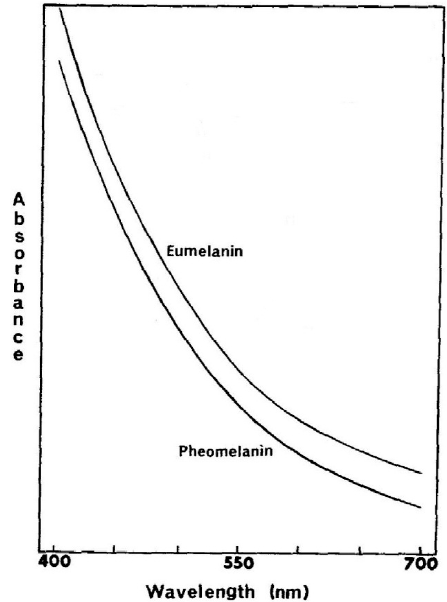
Figure 18. Absorption Spectra of Melanins, adapted from Wolfram et al. [4], with permission from Society of Cosmetic Chemists, 1987.